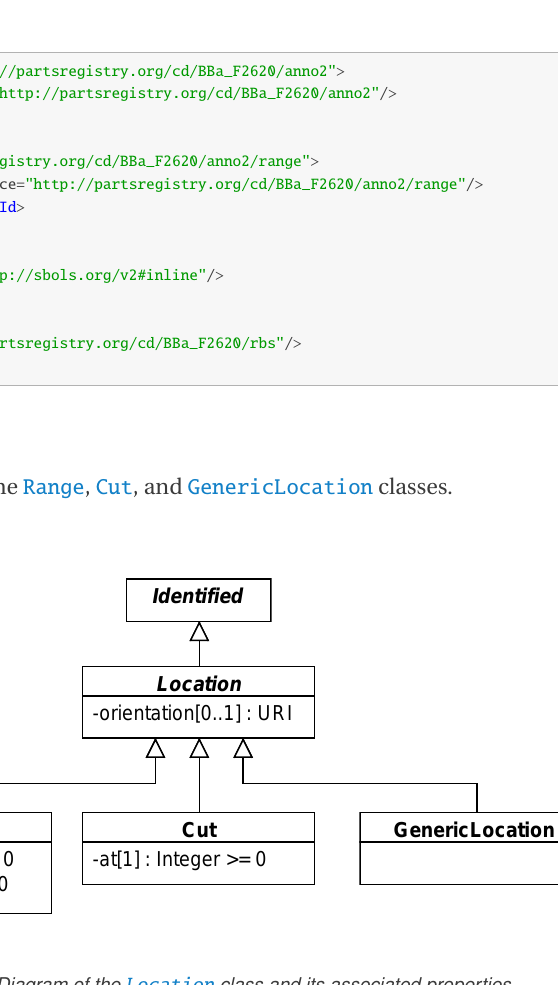
Figure 12: Diagram of the Location class and its associated